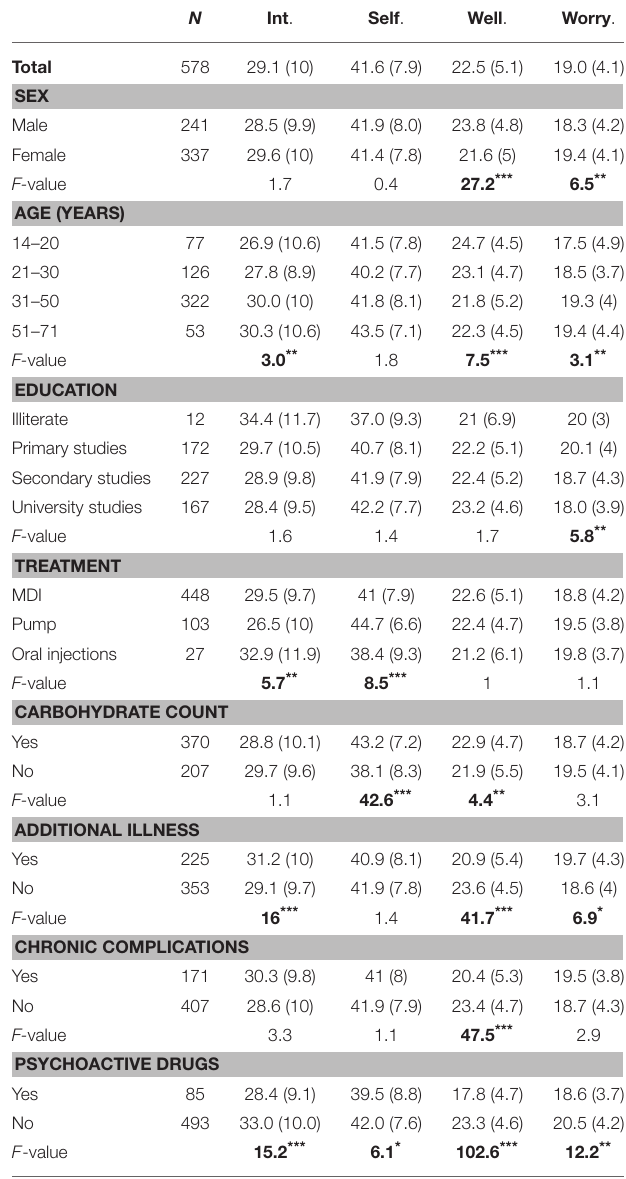
TABLE 8 | Differences between groups using ANOVA. ( N =